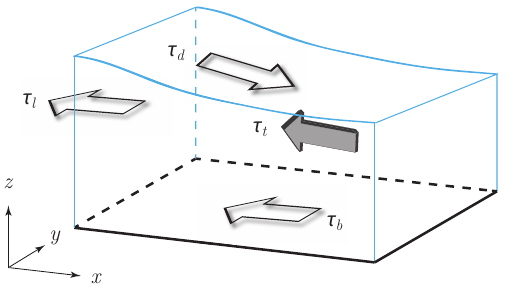
Fig. 5. Schematic of driving stress and resistances acting in a glacier column (after van der Veen, 1999). The gravitational driving stress is collectively balanced by basal drag, lateral drag and resistance due to the longitudinal stress gradients (cf. Eq.